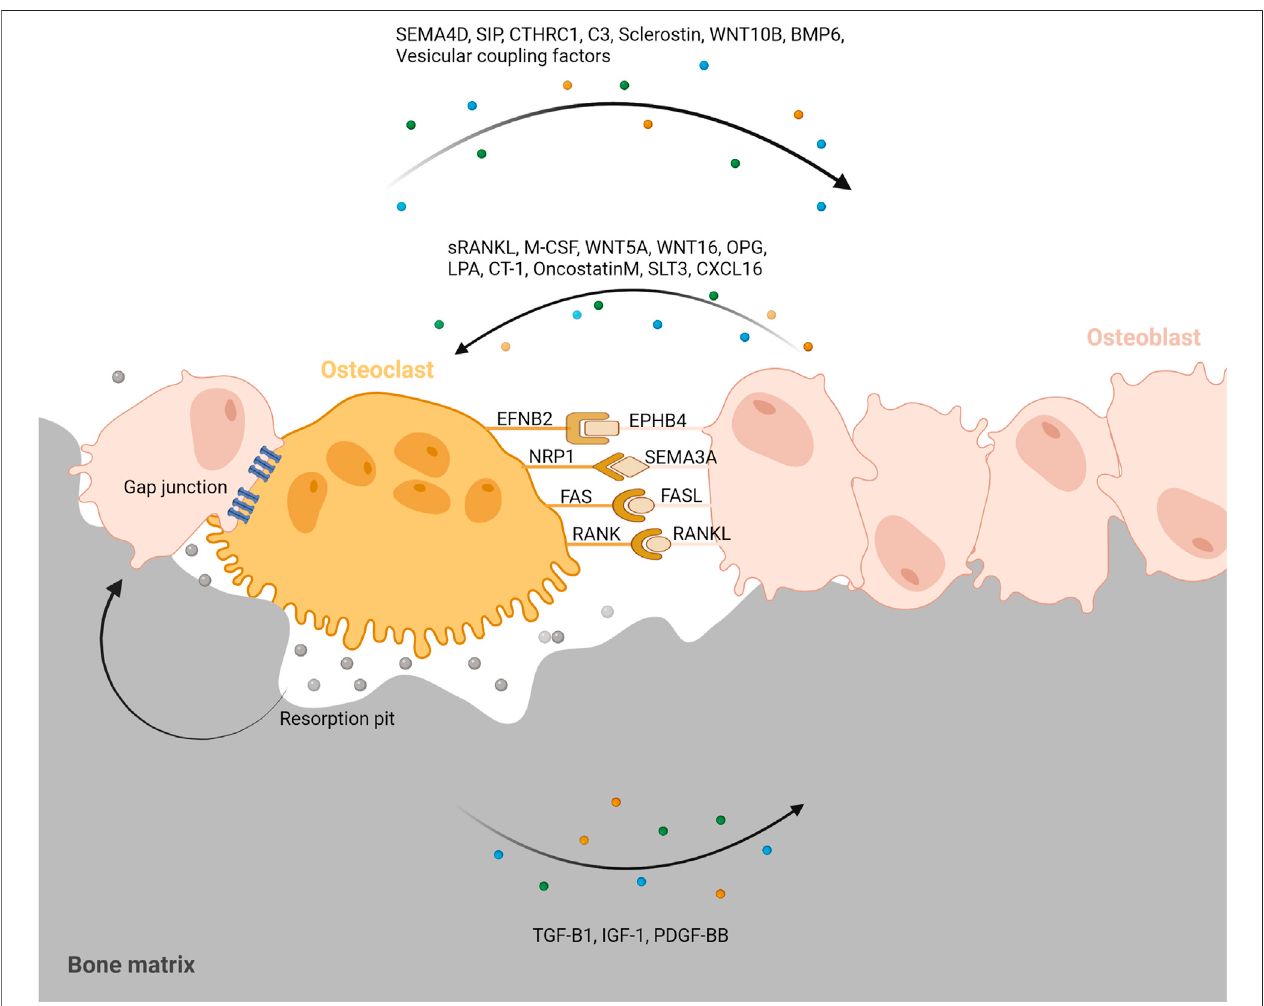
FIGURE 4 | Coupling signals between osteoclast and osteoblast. To accomplish coordination between bone formation and resorption during bone remodeling, communication between osteoclasts and osteoblast lineage cells, as well as interactions with the resorption pit and others are essential. Coupling signals between osteoclast and osteoblast can be classi fi ed into fi ve categories; The membrane-bound coupling signals are mainly composed of fi ve coupling signals: gap junction, EFNB2/EPHB4, NRP1/SEMA3A, FAS/FASL, RANK/RANKL; Soluble coupling signals released from osteoblast mainly refer to the soluble factors acting on osteoclastsreleasedbyosteoblastssuchassRANKL,M-CSF,WNT5A,WNT16,OPG,LPA,CT-1,OncostatinM,SLT3,CXCL16;Solublecouplingsignalsreleasedfrom osteoclast mainlyreferto thesolublefactors acting on osteoblasts released byosteoclasts such as SEMA4D, SIP, CTHRC1, C3,Sclerostin,WNT10B, BMP6, Vesicular coupling factors; Matrix-derived coupling signals are factors released by matrix which is mediated by osteoclast degradation during bone resorption such as TGF-B1, IGF-1, PDGF-BB; Vesicular coupling signals mainly refers to exosomes, microvesicles, and apoptotic bodies. These membrane-containing EVs can deliver proteins, lipids andmRNAsthroughexocytosisand endocytosistopromote coupling. Furthermore,theresorptionpit,cellularcanopy,andreversal phasecouldalsoplay arolein the coupling between osteoclast and osteoblast.